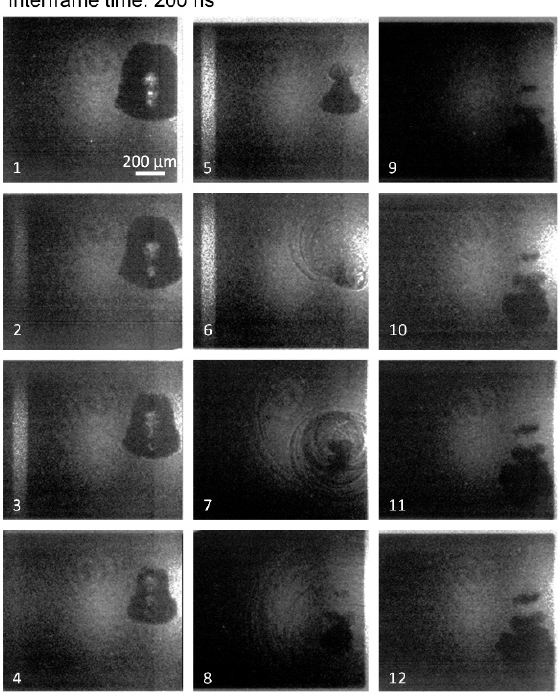
Figure 5. High-speed video imaging of a vertically elongated bubble. The series of photos are numbered 1 to 12 over time. A first shock wave is formed at the top of the bubble in photo 5, followed by a second shock wave at the bottom of the bubble in photo 7. This collapse type is classified to the elongated bubbles. Camera settings are: 5 million frames/s, and 5 ns exposure time. The scale bar is 200 µ